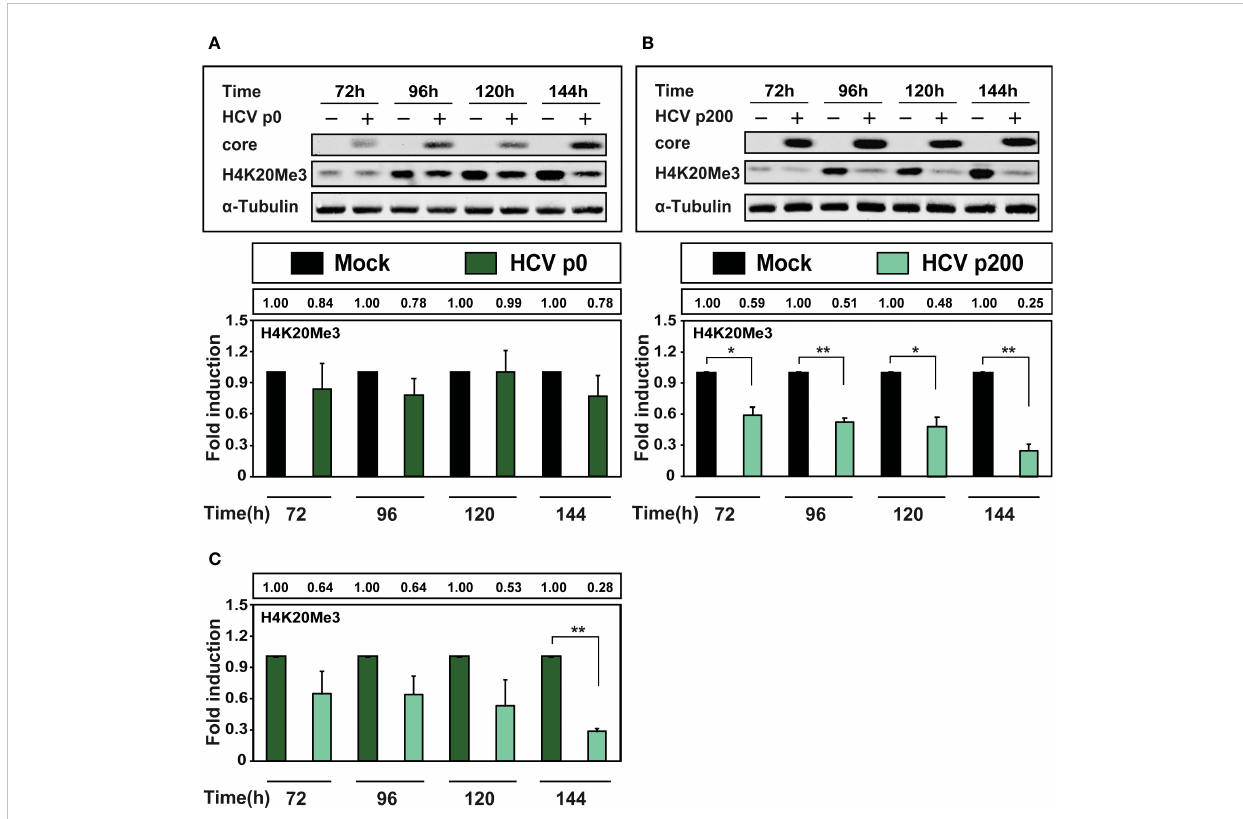
FIGURE 5 Comparison of the effect of HCV infection on the level of H4K20Me3. Huh-7.5 reporter cells were either mock-infected or infected with HCV p0 or HCV p200 at a MOI of 0.03 TCID 50 /cell, and cellular extracts were prepared at the indicated times post-infection. Viral core protein, cellular H4K20Me3, and a -tubulin (used as loading control) were visualized by Western blot. (A) Upper panel: Western blot analysis of cells infected with HCV p0; below, densitometry quanti fi cations (bars) with numerical values written in the box above the panel; Times post-infection are indicated in abscissa. (B) Same as A but for HCV p200-infected cells. (C) Same as (A, B) but with the H4K20Me3 levels in HCV-infected cells expressed as the fold induction relative to the corresponding value for the HCV p0 infected cells. Results are the average of three independent experiments (biological triplicate). Asterisks indicate statistical signi fi cance as follows: *p<0.05; **p<0.01; unpaired